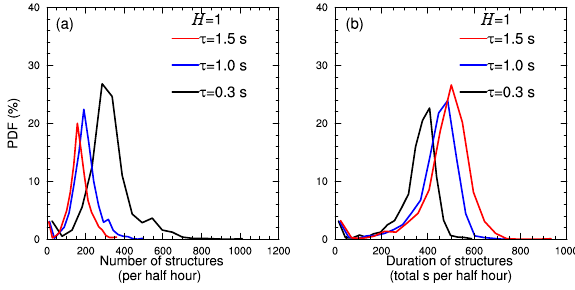
Figure A3 . Probability distribution function of (a) the number of coherent structures 865 Fig. A3. Probability distribution function of (a) the number of co- and (b) the average duration of coherent structures (seconds) for the Q-­‐H method for a 866 herent structures and (b) the average duration of coherent structures (seconds) for the Q-H method for a constant hole-size ( H = 1) and constant hole-­‐size ( H = 1) and a range of time frequency parameters ( τ = 0.3-­‐1.5 s). 867 a range of time frequency parameters ( τ = 0 . 3 − 868